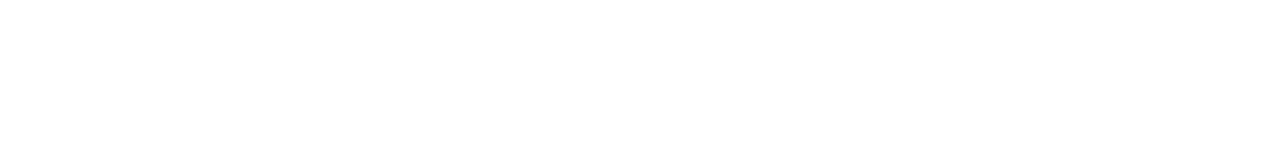
Fig 5. The principal stress dynamics change throughout the depth of non-reinforced slab at the slab-to-column joint (a) and hypothetical punched-out pyramid base level (b): I - 3,7%; 2 - 18,5%; 3 - 33,3%; 4 - 55,5%; 5 - 70%; 6 - 85%; 7 - I 00% - loading stages First vertical cracks appear at the slab-column joint topmost comer at the 33% of the failure loading. While the loading increases to 40-50% of failure value, provid ing further principal stress zone length increase, the ori gin of collapse appears at the distance Y2 h from the comer. The cracks fonned at this zone are inclined at 45°-60° in respect of the slab plane. Collapse zone rap idly develops, increases in width and depth and propa gates towards the lowermost angle of the support. At about 70% of failure loading, an identical kernel of maxi mum principal stresses appears at the slab midpoint, being separated from the original failure zone. This is how the punch-out pyramid is formed. At the failure stage, the very thin compression zone is shear-cut. At the failure stage, the angle of inclination of the side planes of the punched-out pyramid lies within 40°-55° sector (Fig 6). From the graph shown in Fig